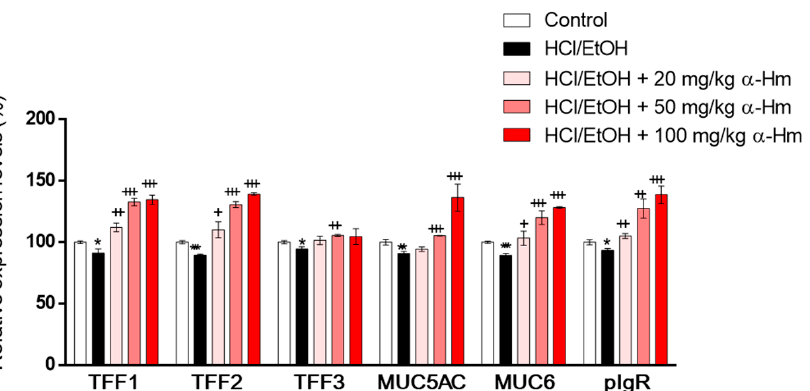
Figure 2. α -Humulene increases the mRNA expression levels of mucus-stabilizing factors in HCl- ethanol-injured stomach tissues. The mRNA expression levels of mucus-stabilizing genes mucin 5ac (Muc5ac), Muc6, trefoil factor 1 (Tff1), Tff2, Tff3 and polymeric immunoglobulin receptor (pIgR) are shown. α -Hm: α -Humulene. + p < 0.05, ++ p < 0.01, +++ p < 0.001, * p < 0.05, ** p < 0.01, *** p < 0.001.